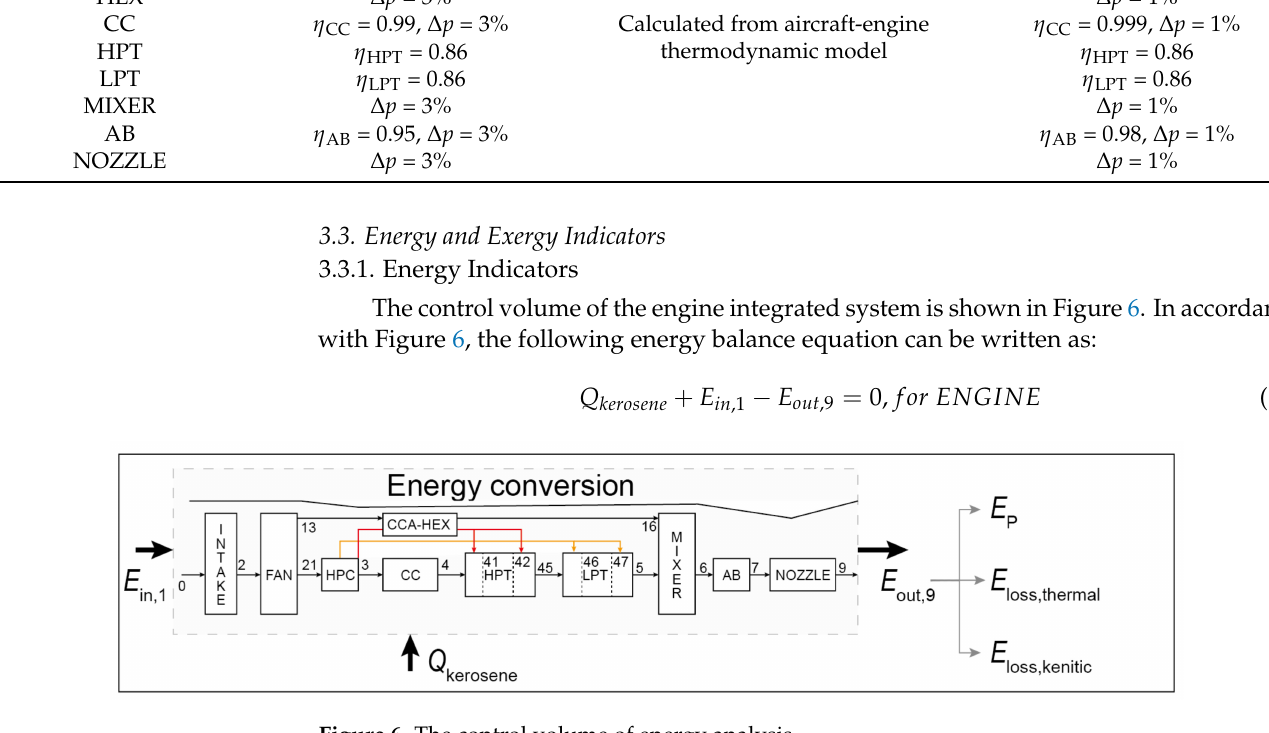
Figure 6. The control volume of energy